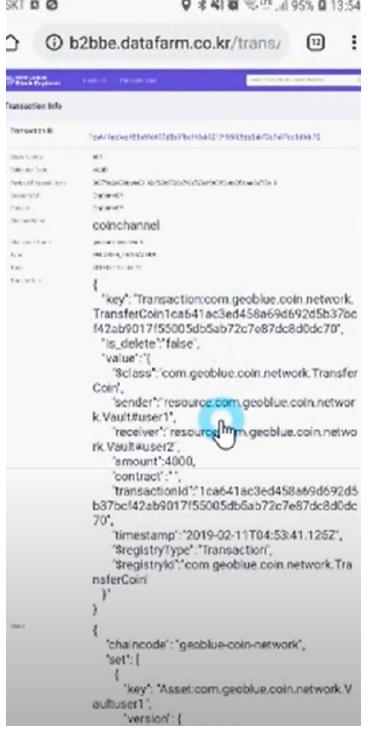
Figure 19. Store inheritances hash tables screen.